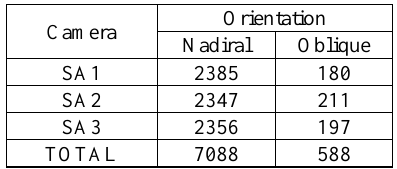
Table 2. Description of the Mandalay dataset with the number of images acquired from each camera.